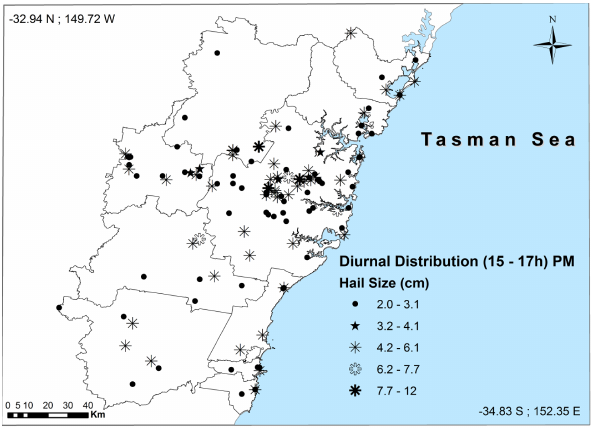
Figure 4. Spatial distribution of the hail events for peak time occur- rences.